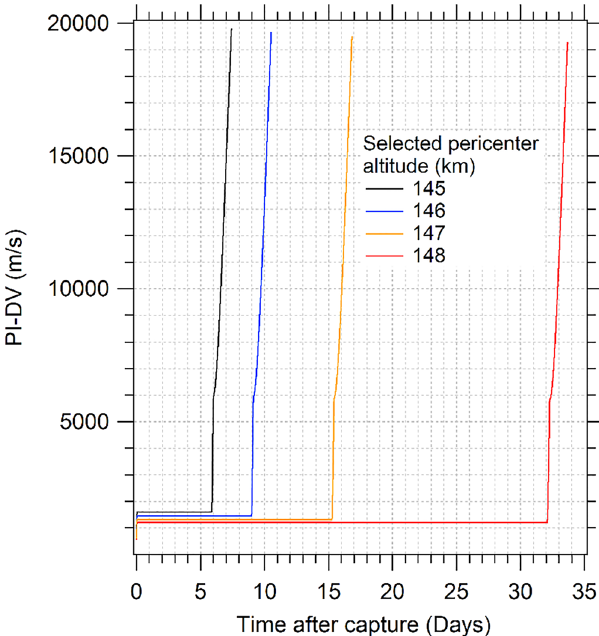
Figure 8. PI-DV as a function of